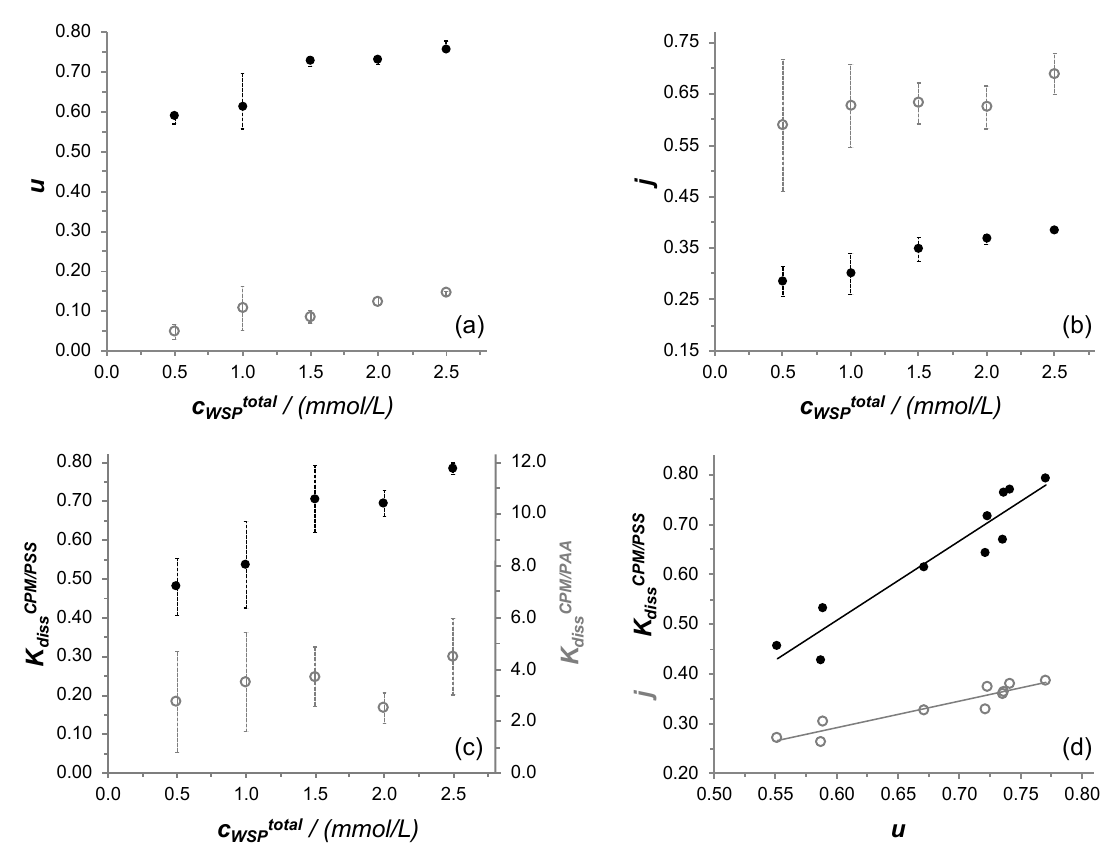
Figure 6. u values ( a ), j values ( b ), and K dissCPM/WSP values ( c ), plotted against the initial polyelectrolyte concentration ( c WSPtotal ) for PAA n /CPM n/2 (grey empty circles) and PSS n /CPM n/2 , systems (black circles). K dissCPM/PSS (black circles) (y = 1.6x − 0.44; R 2 = 0.90) and j (grey empty circles) (y = 0.53x − 0.029; R 2 = 0.89) values plotted against u (plotting each individual experiment for all PSS n /CPM n/2 systems) ( d ).